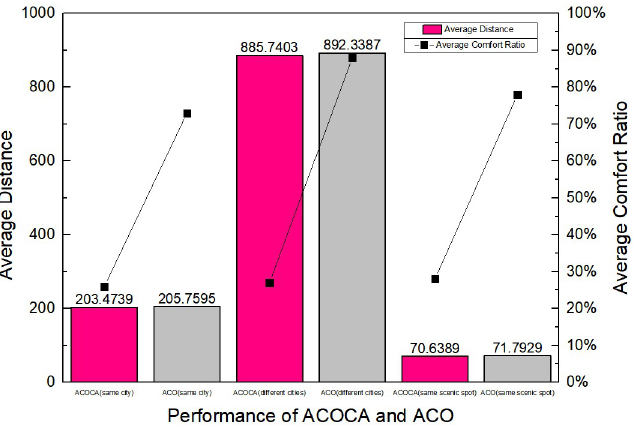
Fig 4. Comparison of two algorithms in convergence time. From the comparison results of the two algorithms in different datasets, the convergence time of ACOCA algorithm is better than that of ACO algorithm.